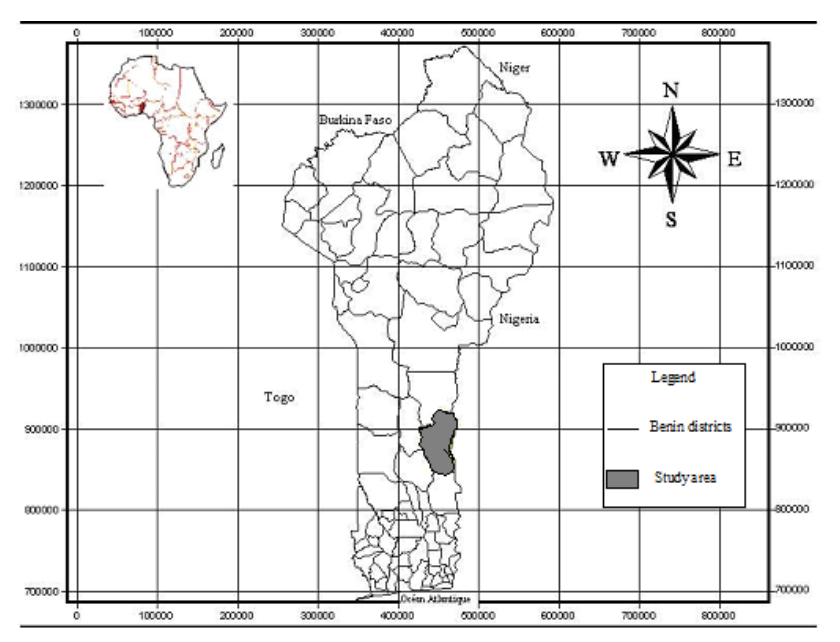
Figure 1. Localization of the study